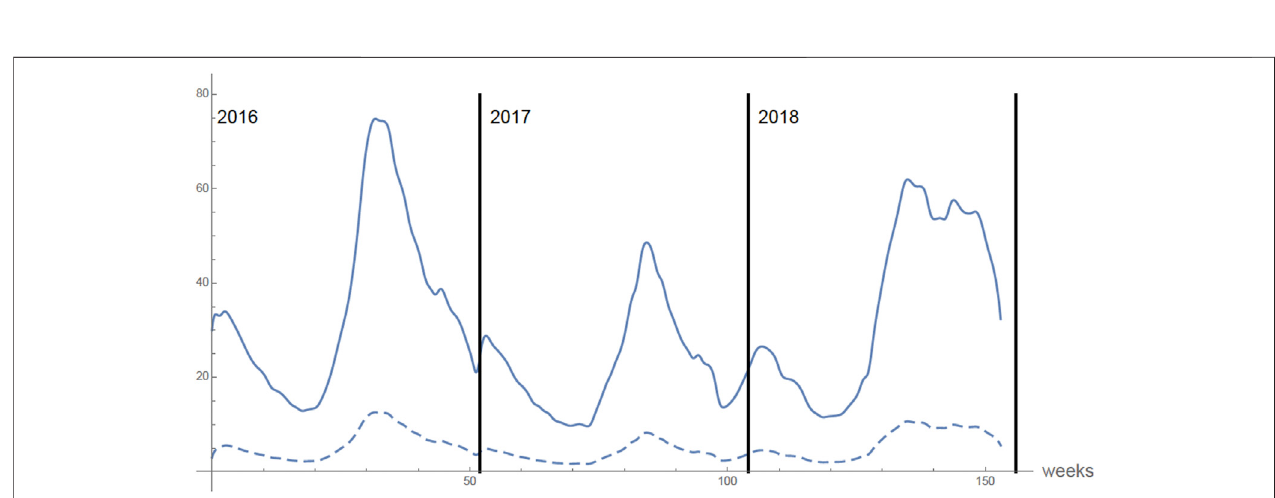
FIGURE7| Noneofthe875,0009 yearsoldsarevaccinated.Thenumberofinfected eachweekofthe875,000vaccinated 9 yearsoldsin2016,2017,2018.The top graph is the number of primary infections each week. The bottom graph is the number of secondary infections each week.